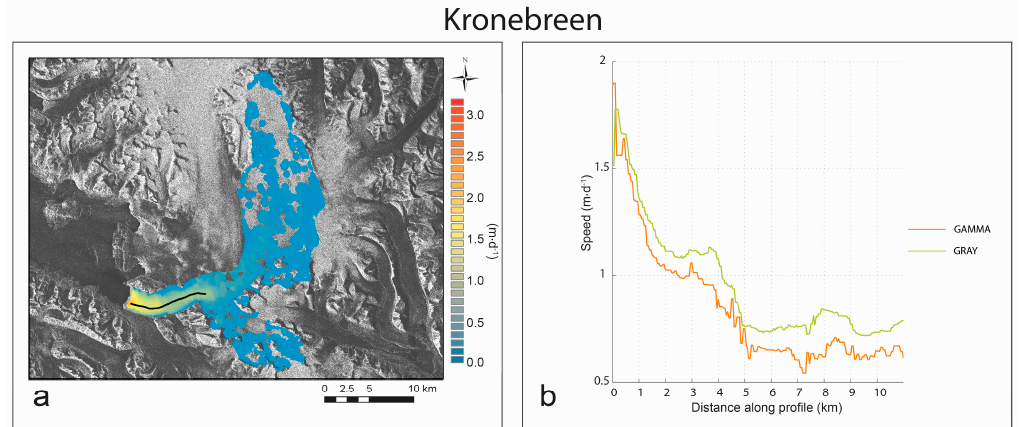
Figure 5. ( a ) Surface speed of Kronebreen (#1 in Figure 3) in NW-Spitsbergen (1–25 January 2013; WF; GRAY); and ( b ) speed profile along the centerline of Kronebreen (orange: GAMMA; green: GRAY).